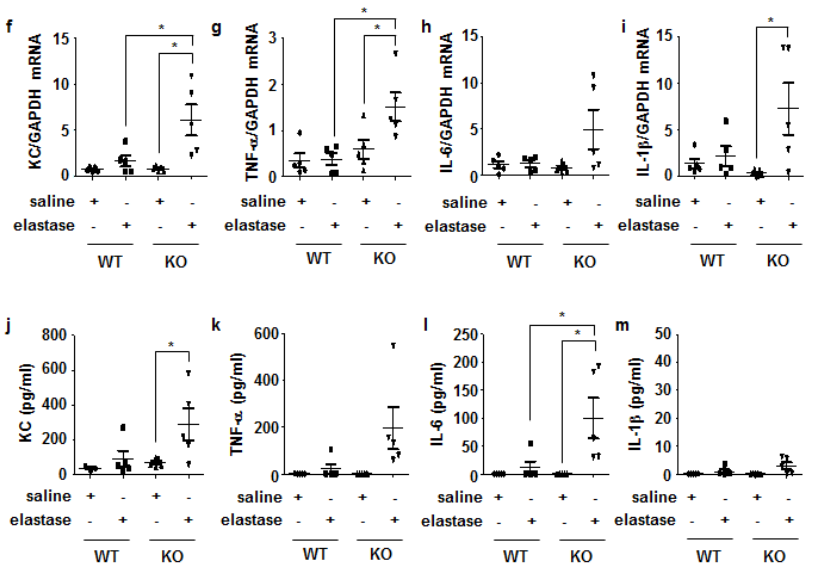
Figure 3. Crbn KO increased elastase-induced inflammation and cellular injury. WT and Crbn KO mice were given 0.5 units of elastase via intratracheal injection. (Day 2: WT-saline n = 5, WT-elastase n = 5, KO-saline n = 5, KO-elastase n = 5, Day 14: WT-saline n = 5, WT-elastase n = 5, KO-saline n = 4, KO-elastase n = 3). ( a ) Representative images of H&E staining in lungs from WT and Crbn KO mice on day 2 (d2) and day 14 (d14) after intratracheal instillation of elastase (×100). ( b , c ) BALF was collected on days 2 and 14 after intratracheal instillation of elastase. Total cells ( b ) and differential cells ( c ) including macrophages and neutrophils in BALF were counted. Data represent the mean ± SE. The concentrations of LDH ( d ) and protein ( e ) in BALF were measured. ( f - i ) Real-time PCR analysis of KC, TNF- α , IL-6, IL-1 β , and GAPDH expression in the lung tissues of WT and Crbn KO mice. ( j - m ) The concentrations of KC, TNF- α , IL-6, and IL-1 β were measured. Data represent the mean ± SE. * p < 0.05, ** p < 0.01, and *** p < 0.001, n.s., not significant.